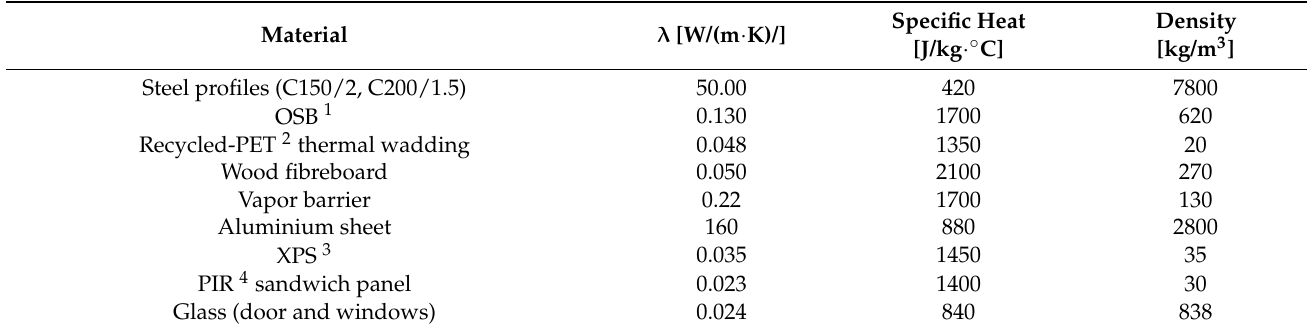
Specific Heat [J/kg ∙ °C] Specific Heat Density [J/kg · ◦ C] [kg/m 3 ]